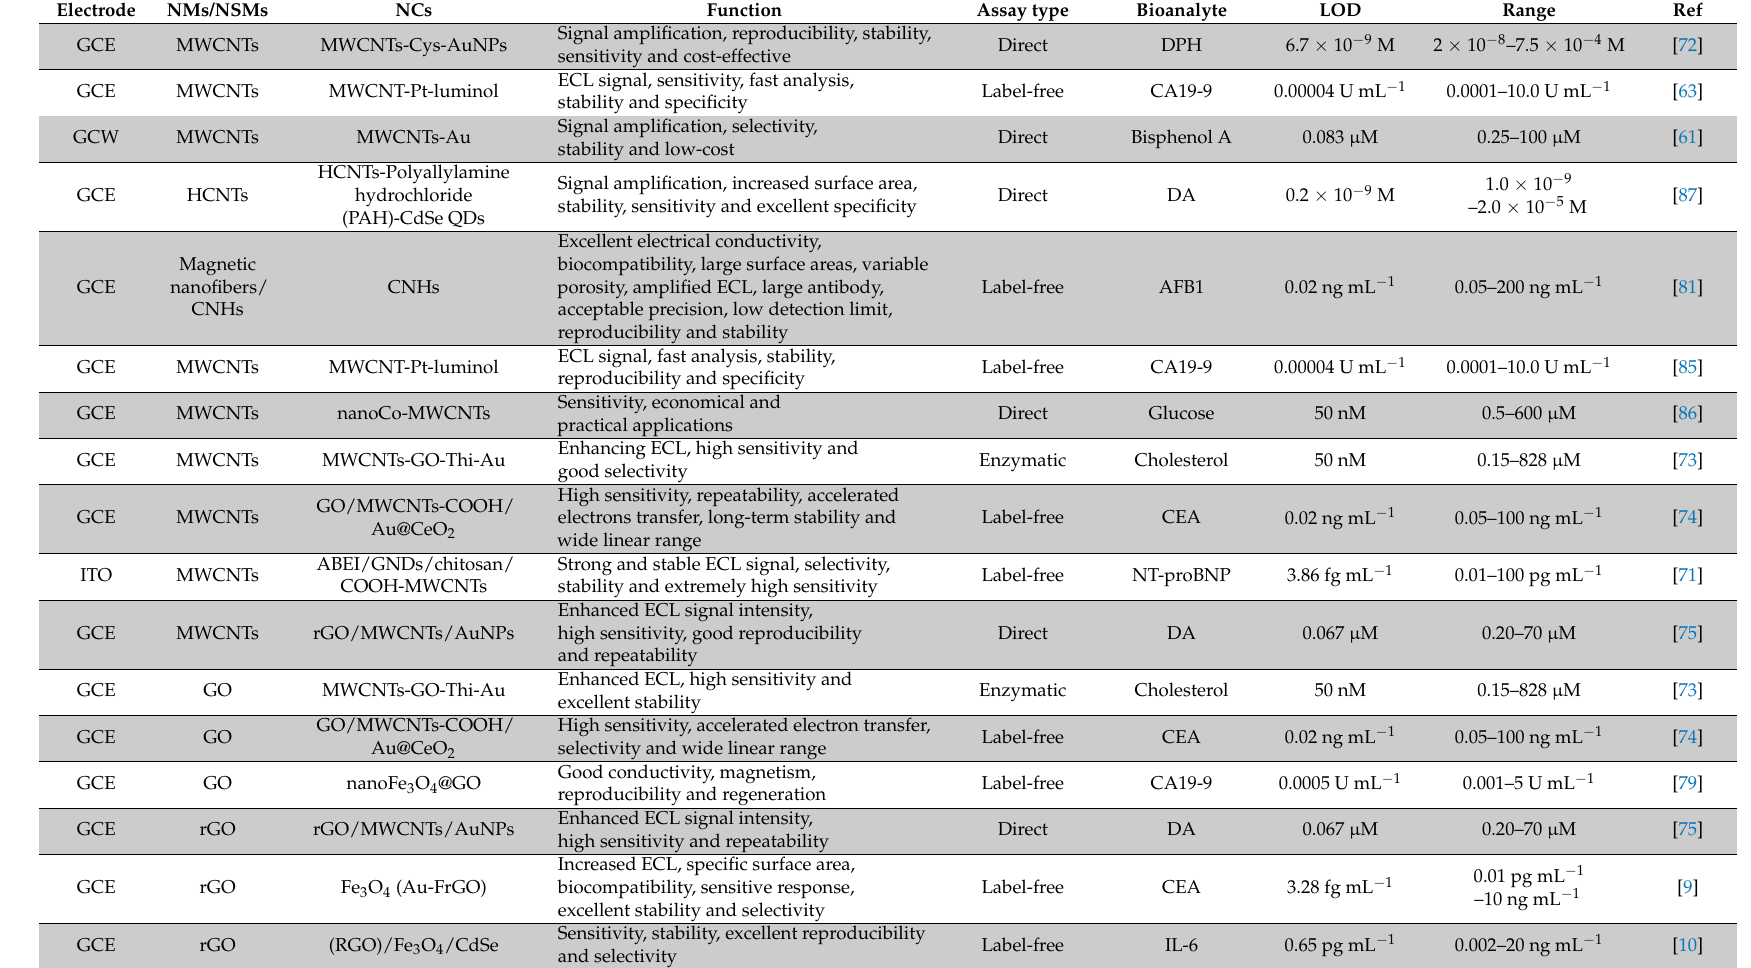
Table 4. CNMs-, CNSMs- and NCs-based